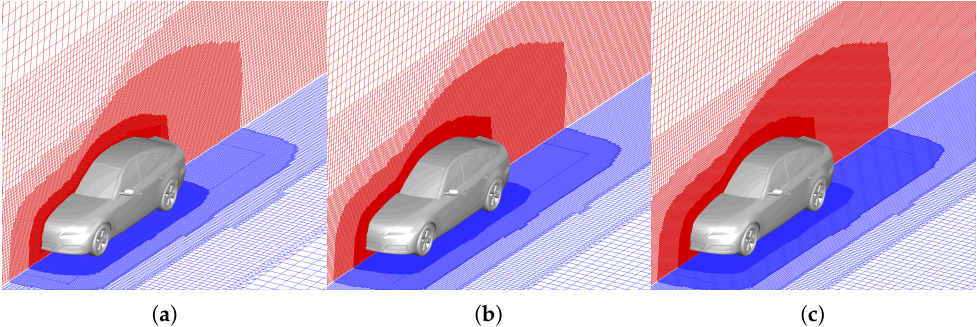
Figure 3. Meshes used in the current simulations: ( a ) coarse (89M voxels), ( b ) medium (174M voxels), ( c ) fine (272M voxels).